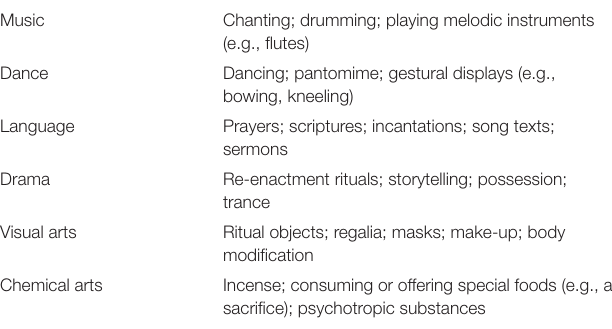
TABLE 1 | Artforms found in religious ceremonial